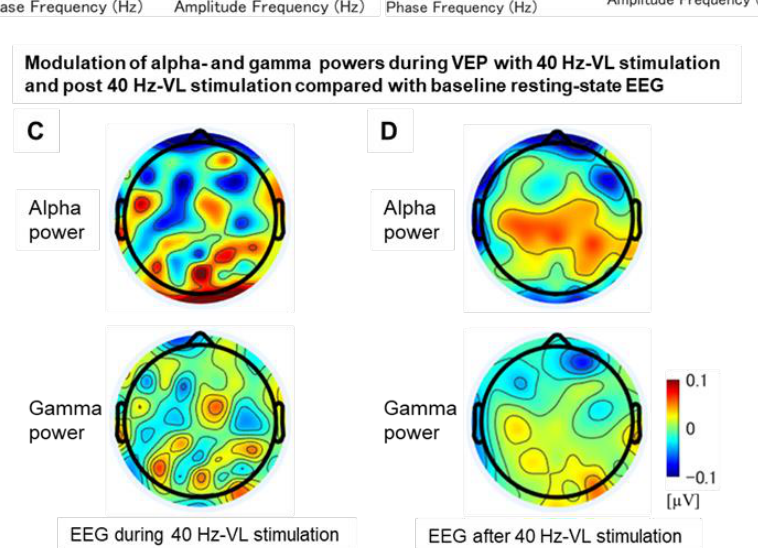
Figure 8. Enhanced alpha-phase and gamma-amplitude coupling and modulation of alpha and gamma power during and after 40 Hz-VL stimulation. ( A , B ) show the comodulogram, where the vertical axis represents the amplitude frequency, and the horizontal axis represents the phase frequency. The alpha-phase and gamma-amplitude coupling, which was significant during and after 40 Hz-VL stimulation, corresponds to the area shown in yellow in the color map display on the comodulogram. The upper row are 2-dimensional display graphs, and the lower row are 3-dimensional display graphs (Z-axis is the modulation index value). ( A ) demonstrated a significant increase of alpha-phase and gamma-amplitude coupling at the left prefrontal area (F5 electrode site: t 38 = 2.08, p = 0.029) during the 40 Hz-VL stimulation (i.e., VEP with 40 Hz-VL minus baseline EEG); ( B ) indicated a significant increase of alpha-phase and gamma-amplitude coupling at the right central area (C4 electrode site: t 38 = 2.07, p = 0.033) after the 40 Hz-VL stimulation (i.e., post-EEG with 40 Hz-VL minus baseline EEG); ( C ) displays EEG topological plots illustrating the changes in alpha- and gamma-band PSDs (0–1000 ms) during 40 Hz-VL stimulation compared to baseline resting-state EEG; ( D ) represents EEG topological plots depicting the changes in alpha- and gamma-band PSDs (0–1000 ms) after 40 Hz-VL stimulation compared to baseline resting-state